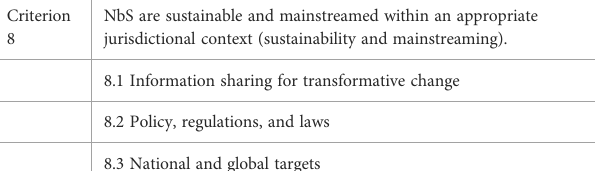
TABLE 1 The eight criteria of the IUCN Global Standard for Nature- based Solutions ™ and some keywords from each of the 28 indicators (for indicators ’ full titles and explanations, see IUCN (2020a and 2020b). The criteria of the IUCN Global Standard for Nature-based